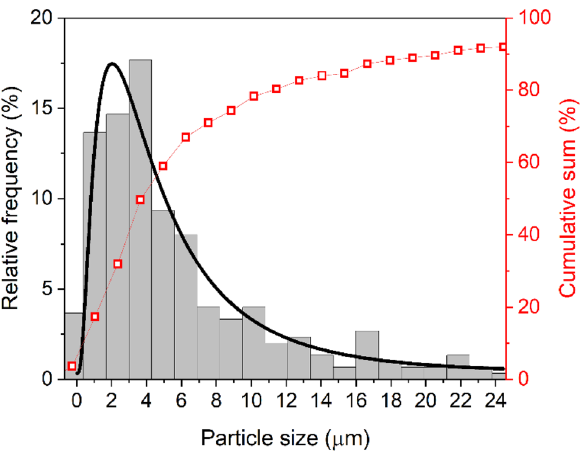
Figure 2. Particle size distribution for the sample GPM5 (glass–ceramic powder annealed for 5 h at 830 °C).